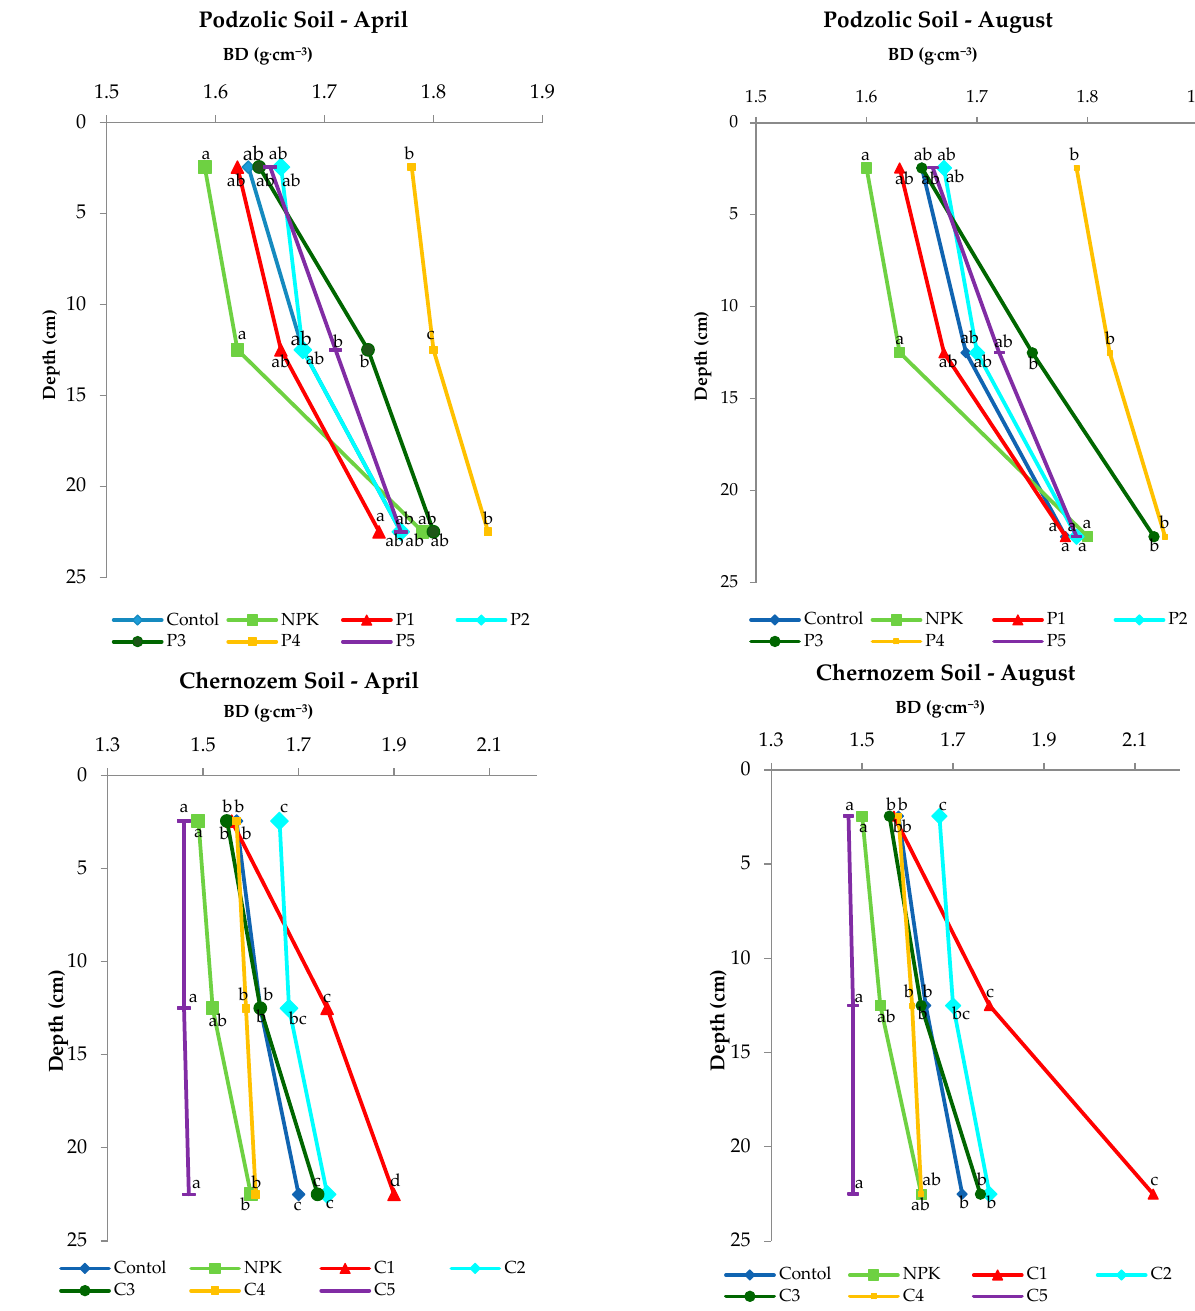
Figure 2. Changes in soil bulk density (BD) with depth in the experimental variants of podzolic and chernozem soils.